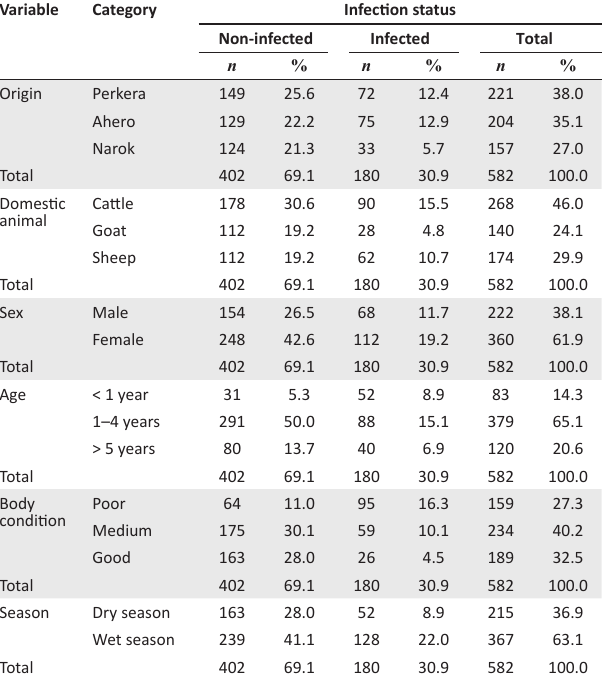
TABLE 1: Overall prevalence and infection status of fasciolosis with different variables. Variable Category Infection status